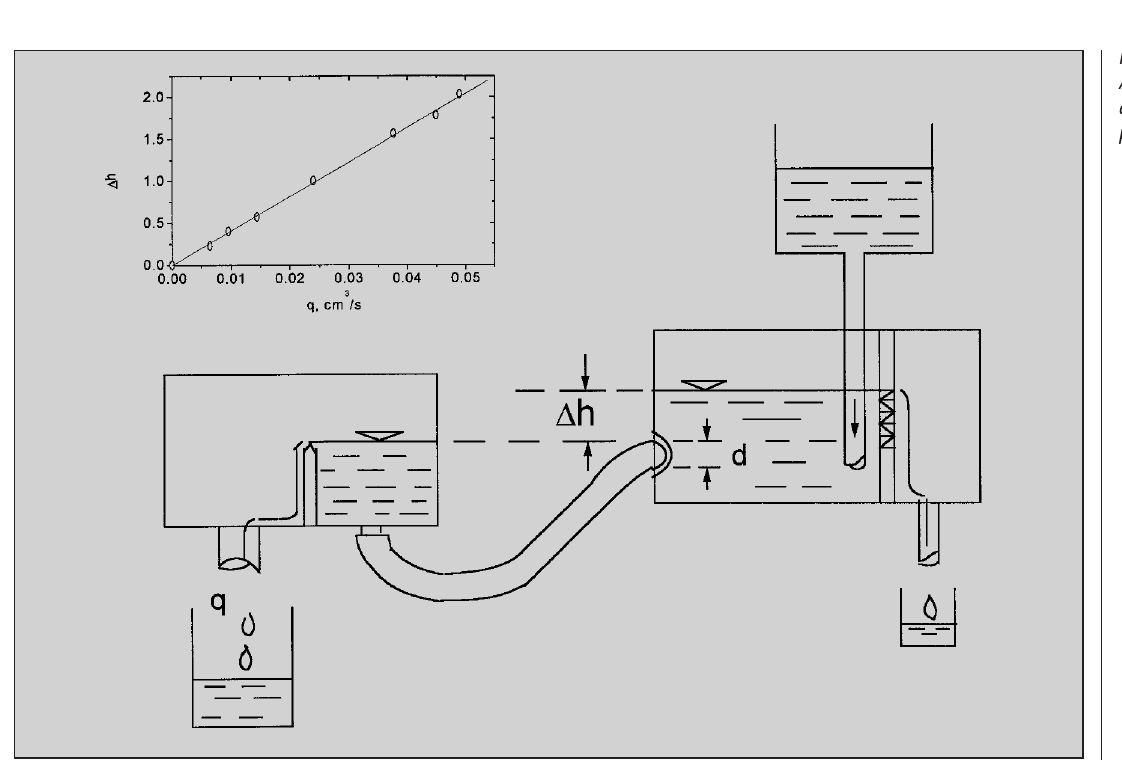
Figure 6: A viscous model device for determining of the drainage pipe hydraulic